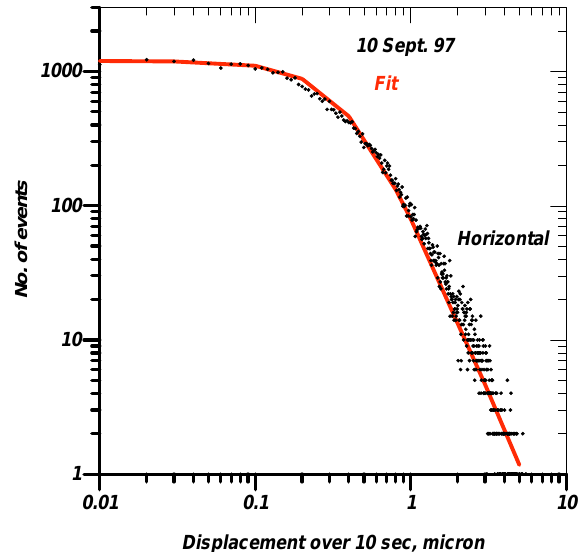
FIG. 5. (Color) Distribution of horizontal ground displacements over 10 s